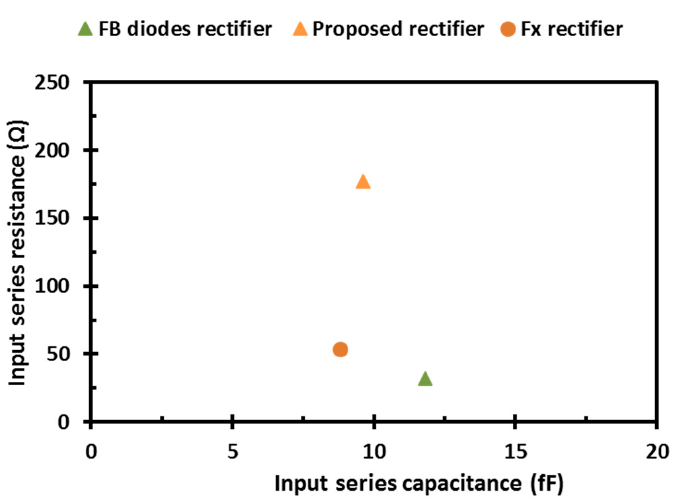
Figure 9. Input impedance of the proposed rectifier with the conventional FX and FB diodes rectifiers.